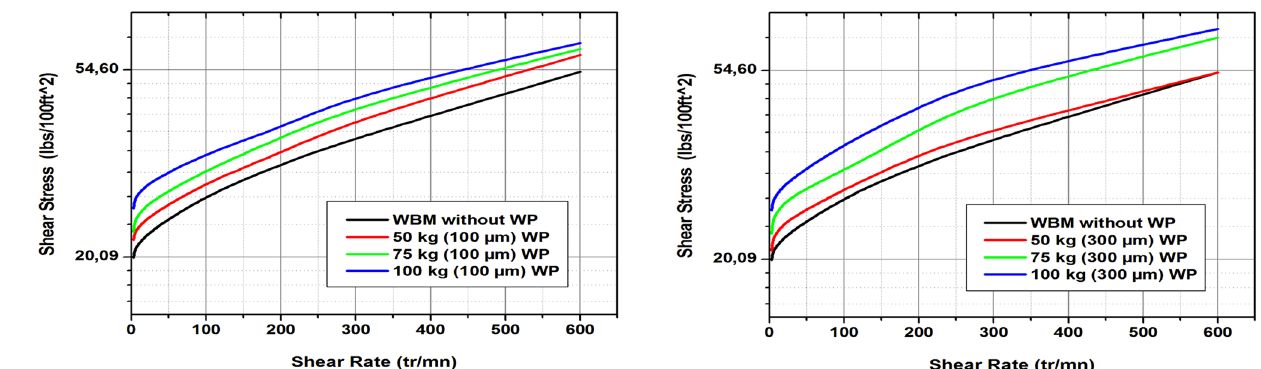
Fig. 1 Wood powder used (wastes of Aleppo pine). a SEM, b XRD